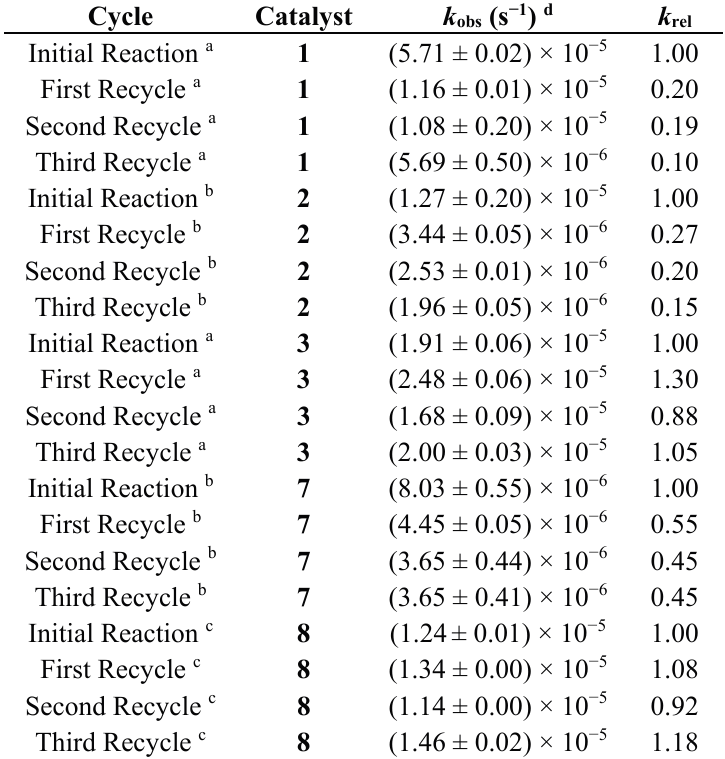
Table 2. Observed pseudo first-order rate constants ( k rel ) and relative rates ( k rel ) for bromination of 4-pentenoic acid ( 19 ) with TEOS xerogel-sequestered 1 – 3 , 7 , and 8 for initial reaction and three recycles of the xerogel-catalyst combination in pH 6.2 phosphate buffer a